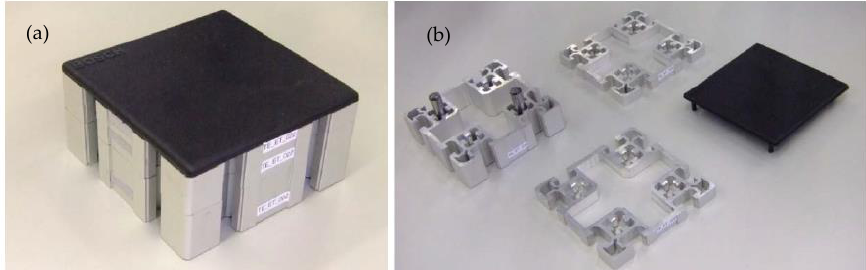
Figure 3. ( a ) Finished product; ( b ) Products’ components.